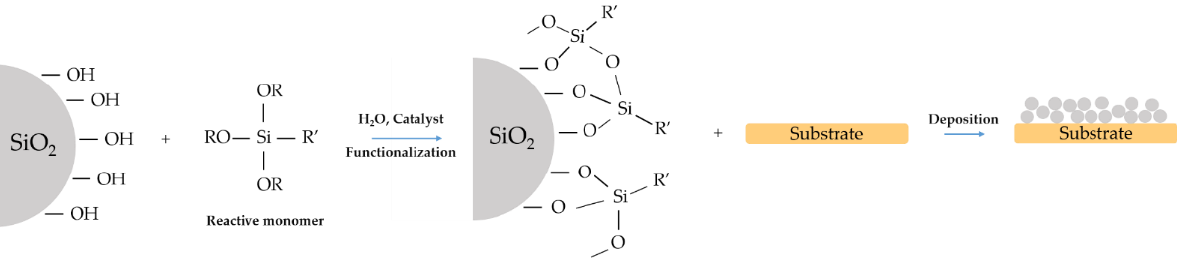
Figure 13. Example scheme of a synthesis of a film with modified nanoparticles.